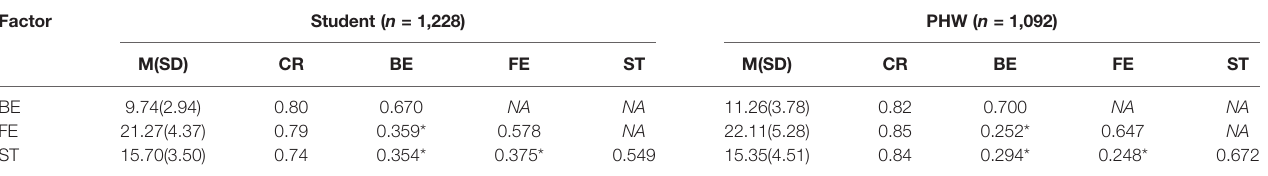
TABLE 3 | Reliabilities and correlations between SF-CAMI subscales in medical students and primary health workers. Factor Student ( n = 1,228) PHW ( n = 1,092) M(SD) CR BE FE ST M(SD)